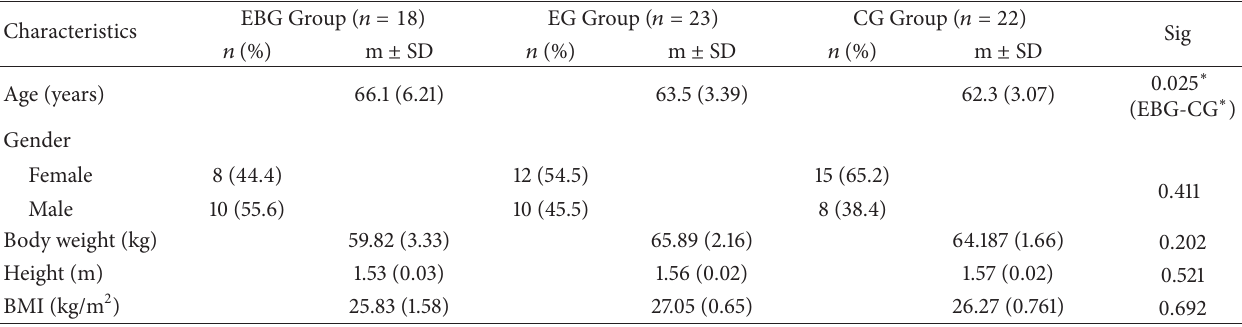
Table 2: Characteristics of study participants ( 𝑛 = 63 ) at baseline.